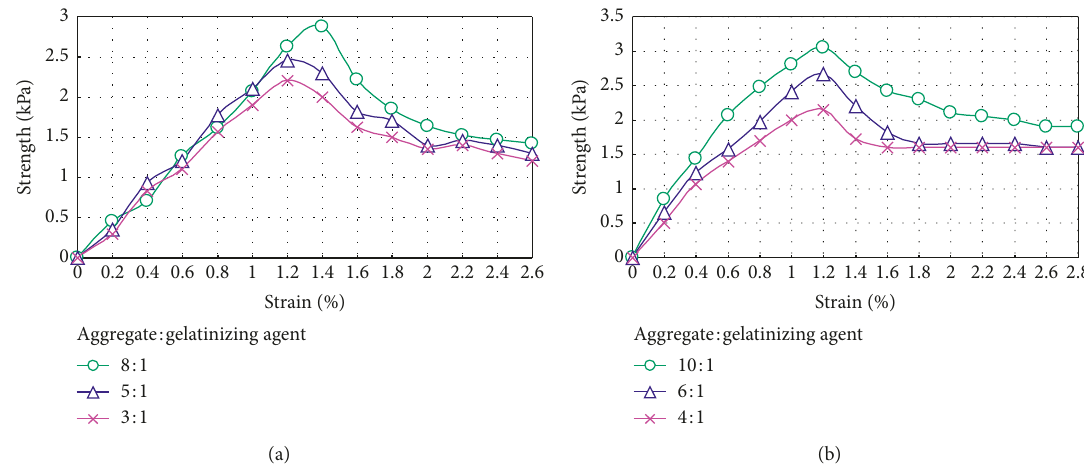
Figure 4: Stress-strain curve in various ratios between the aggregate and the gelatinizing agent. (a) Ratio between sand and soil 1:1. (b) Ratio between sand and soil 1 :3.